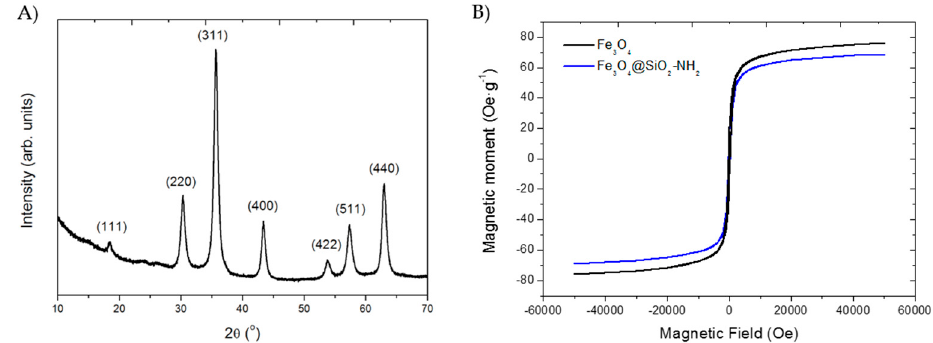
Figure 7. ( A ) XRD pattern of nude MNPs. The hkl Miller indexes corresponding to the six diffraction maxima are indicated on the top of each signal. ( B ) Variation of the magnetic moment vs. applied field. Black line is MNPs and blue line is AMNPs.